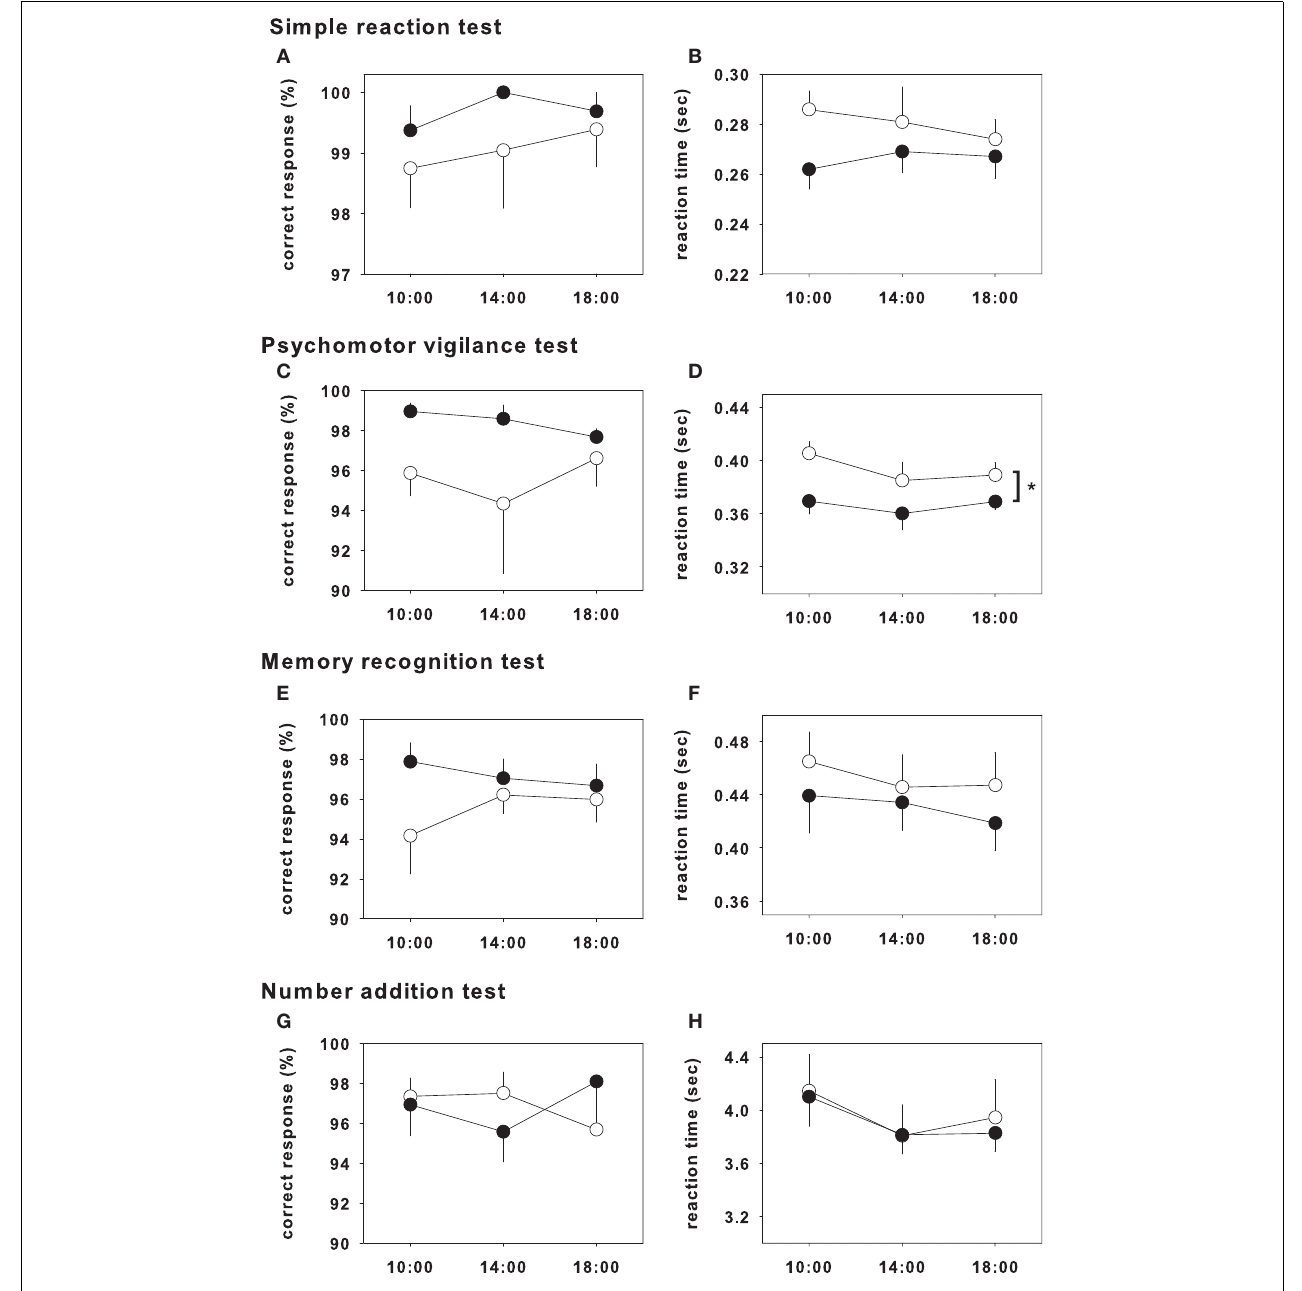
memory recognition test (E,F) and number addition test (G,H) showed no significance. Psychomotor vigilance test showed significant effects in reaction time (D) , however that of correct response did not showed significance (C)